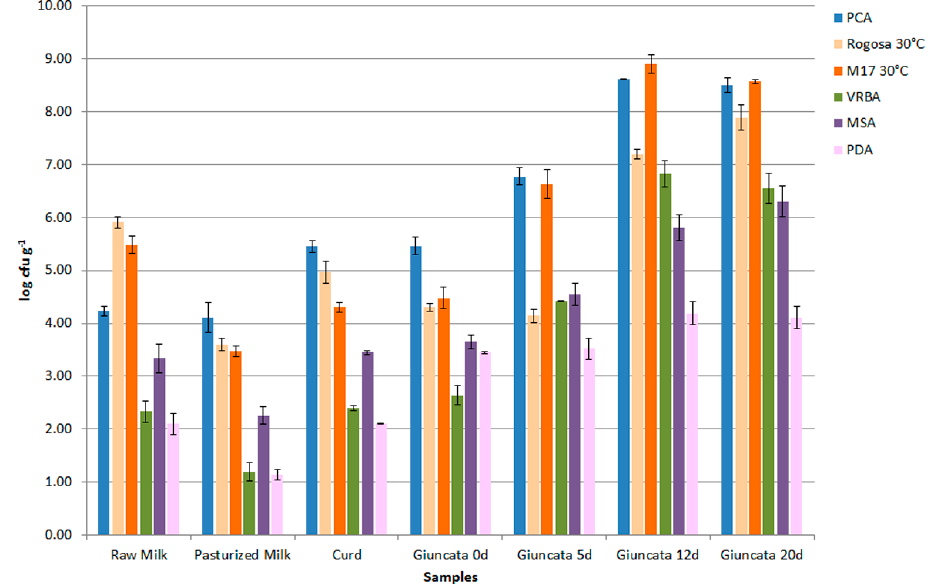
Table 1. Occurrence of different species of lactic acid bacteria during cheese-making of Giuncata leccese cheese. Number of isolates from each sample with isolation dilution is reported in parentheses.